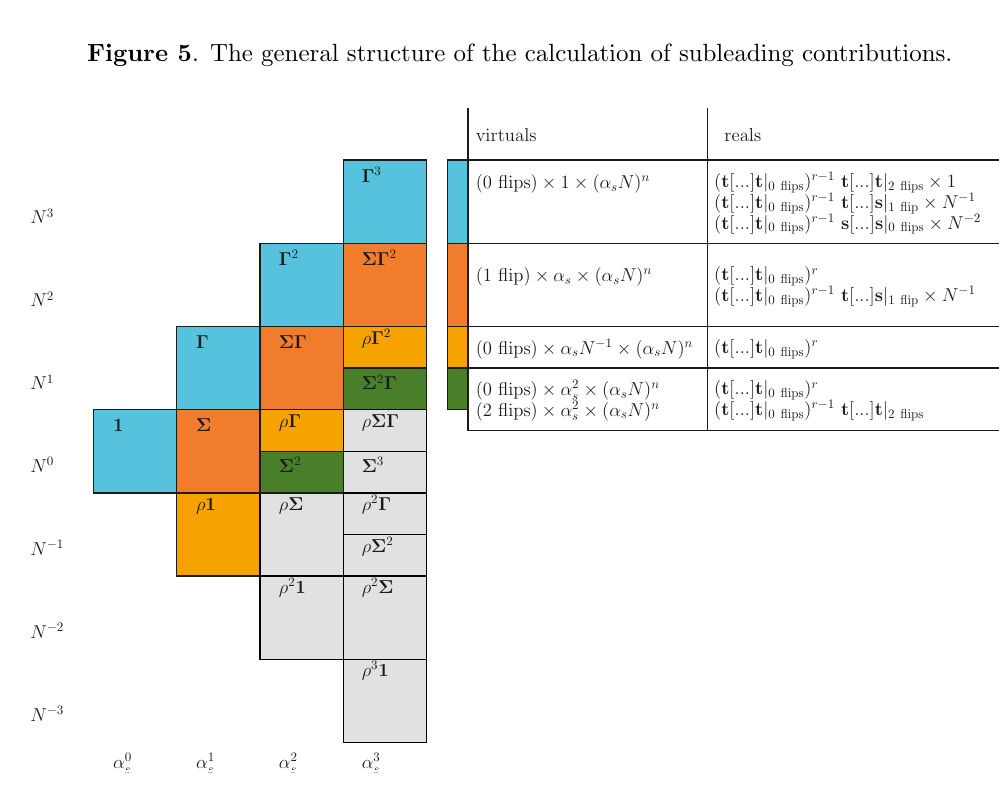
Figure 6 . The counting of next-to-leading colour contributions. We aim to perform a resummation in all powers of the t’Hooft coupling (cid:11) s N 1. In the set of boxes shown we count, for the virtual (cid:24) evolution operator, increasing powers of (cid:11) s from left to right, and decreasing powers of N from top to bottom, with N 0 in the middle row. The e(cid:11)ect of r real emissions is indicated in the rightmost column of the (cid:12)gure and any 1 =N suppression due to the scalar product matrix is indicated by the number of (cid:13)ips. See the text for more